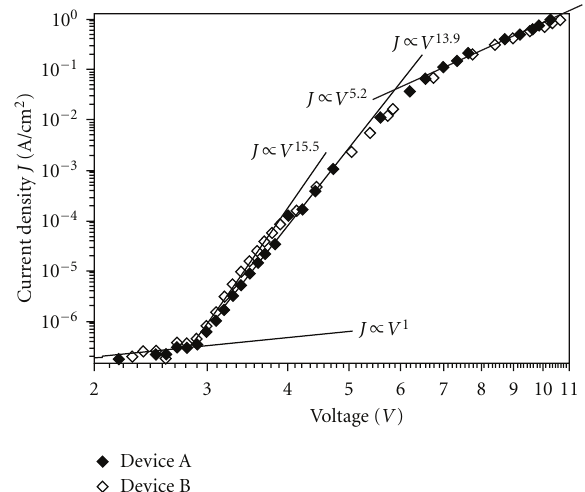
Figure 4: The current density-voltage characteristics of Devices A and B.